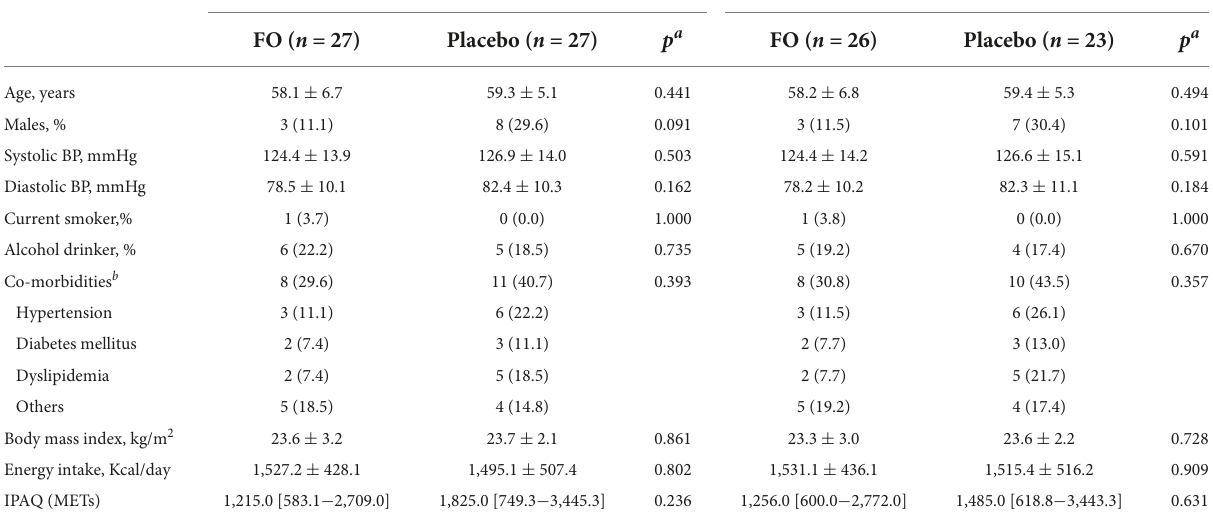
TABLE 1 Baseline characteristics of the study group.